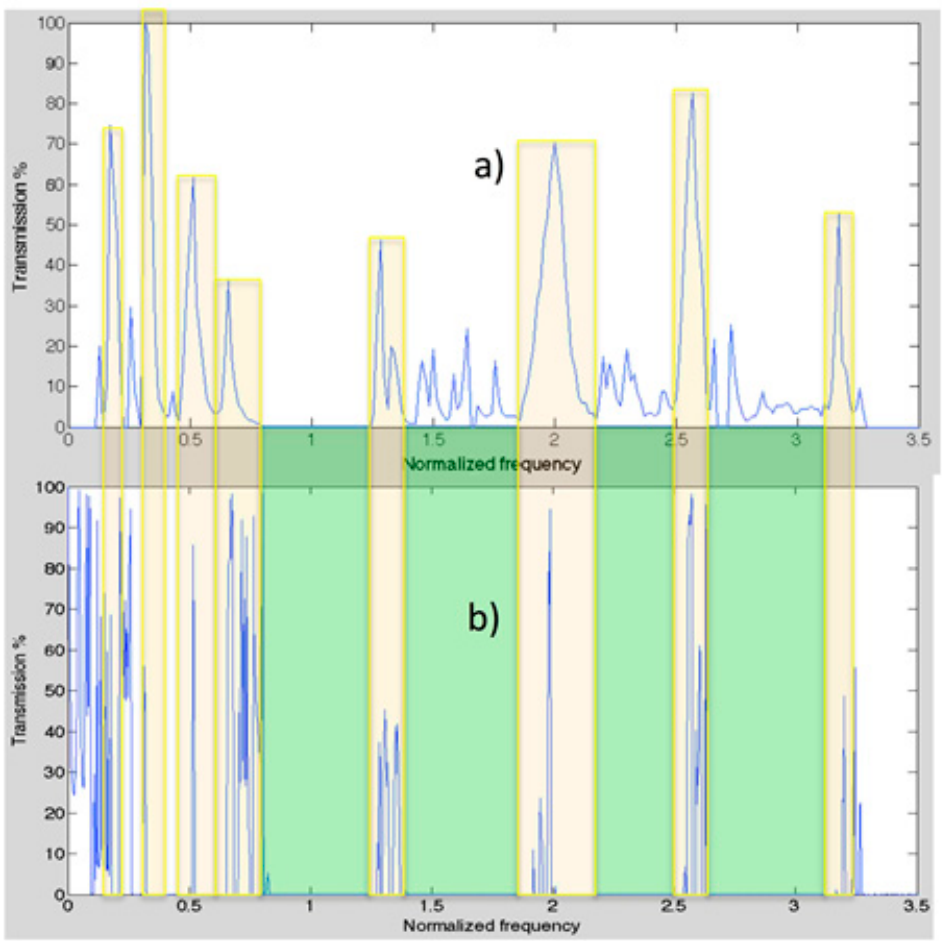
Figure 6. Comparison of experimental ( a ) and theoretical ( b ) electrical transport bands.